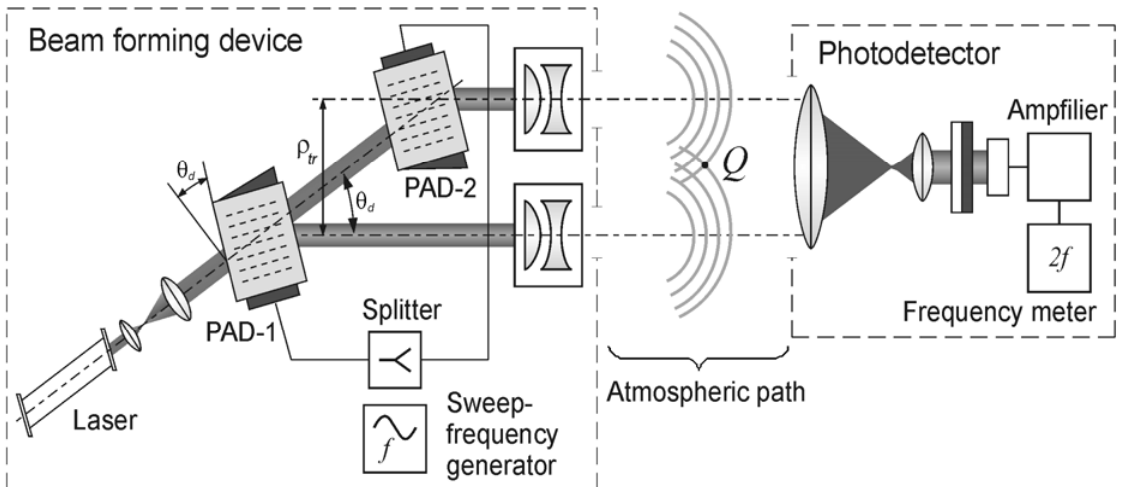
Figure 1. The schematic of the atmospheric laser